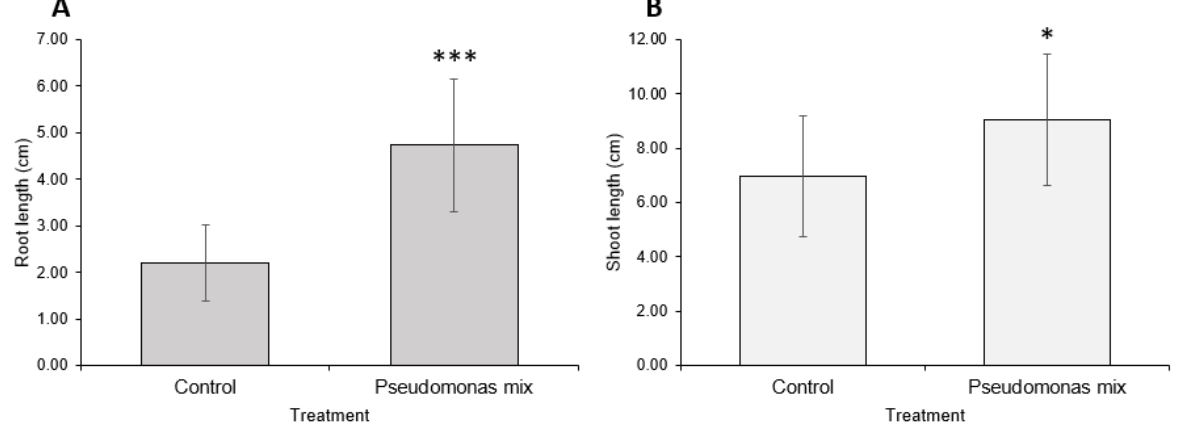
Figure 9. Coriander growth promotion by a mix of Pseudomonas sp. strains. ( A ) Root and ( B ) shoot lengths of 2-week-old coriander seedlings inoculated with Pseudomonas sp. P3AW, AY2, WC, and WCY. Error bars represent standard deviation. Asterisks represent the p value of the Student’s T-test conducted between the control and the experimental group. ns = p > 0.05, * = p ≤ 0.05, ** = p ≤ 0.01, *** = p ≤ 0.001.